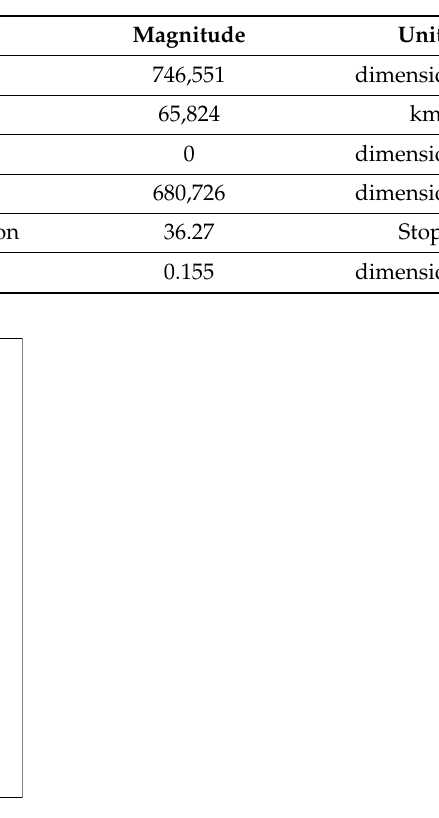
Table 4. Examples of the data generated for the betweenness centrality.